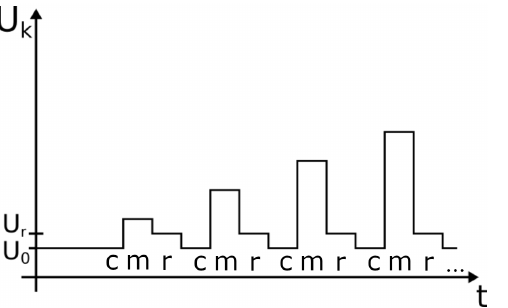
Figure 5. Schematic potential ramp on the electron cooler gun in DR